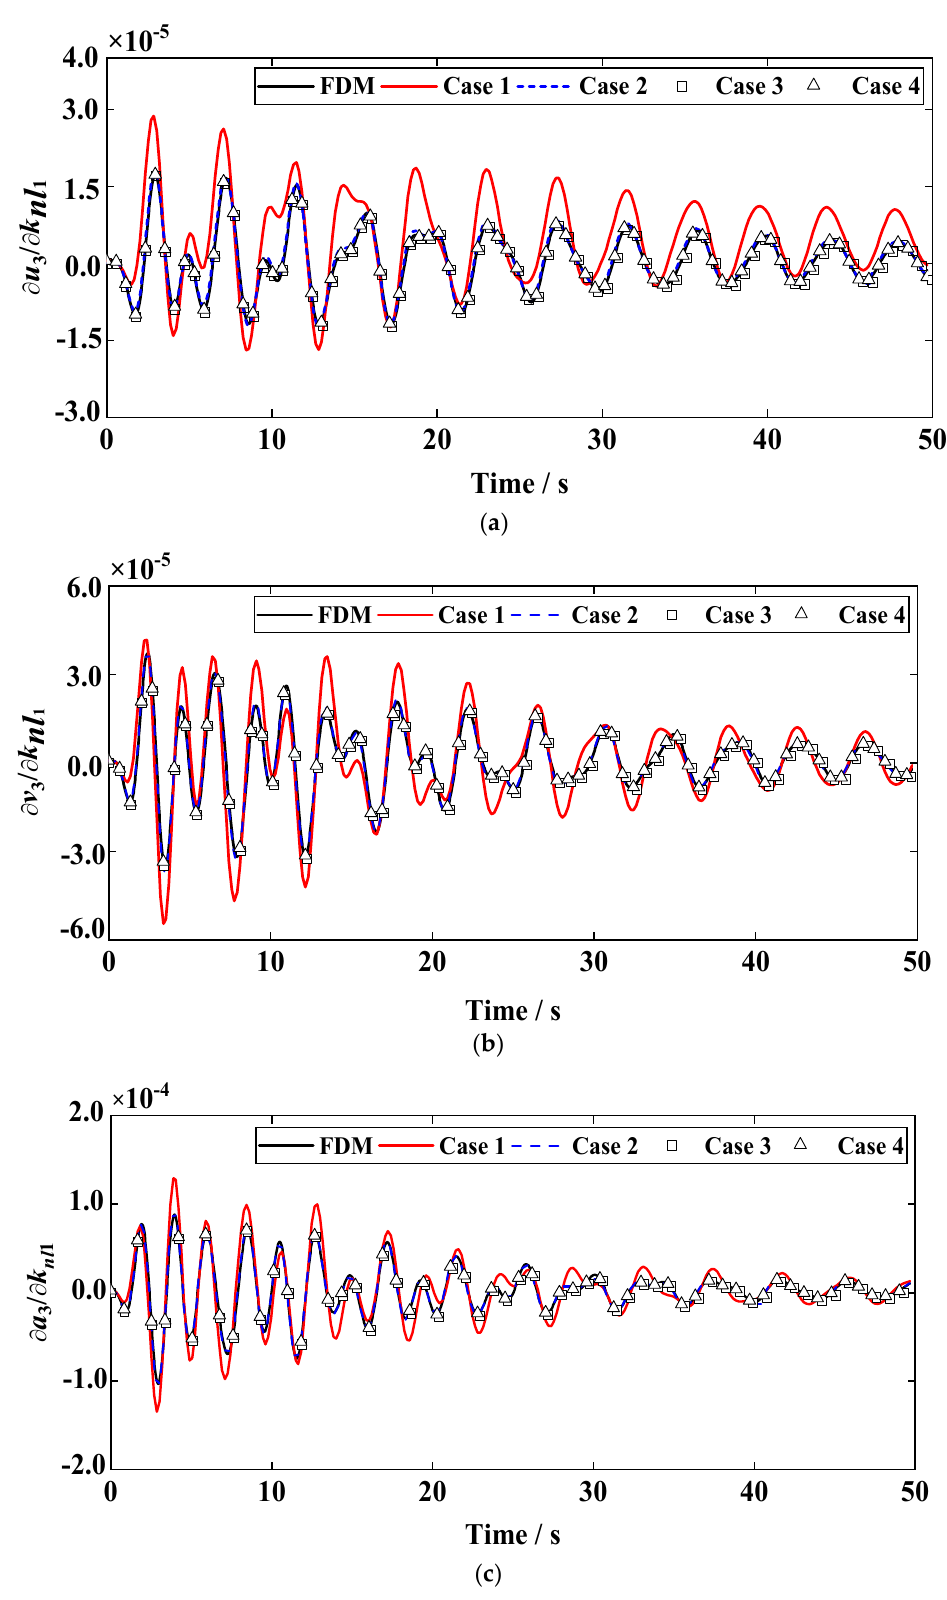
Figure 6. Sensitivities of the 3rd DOF ( a ) displacement, ( b ) velocity, and ( c ) acceleration with respect to the k nl at different time steps.